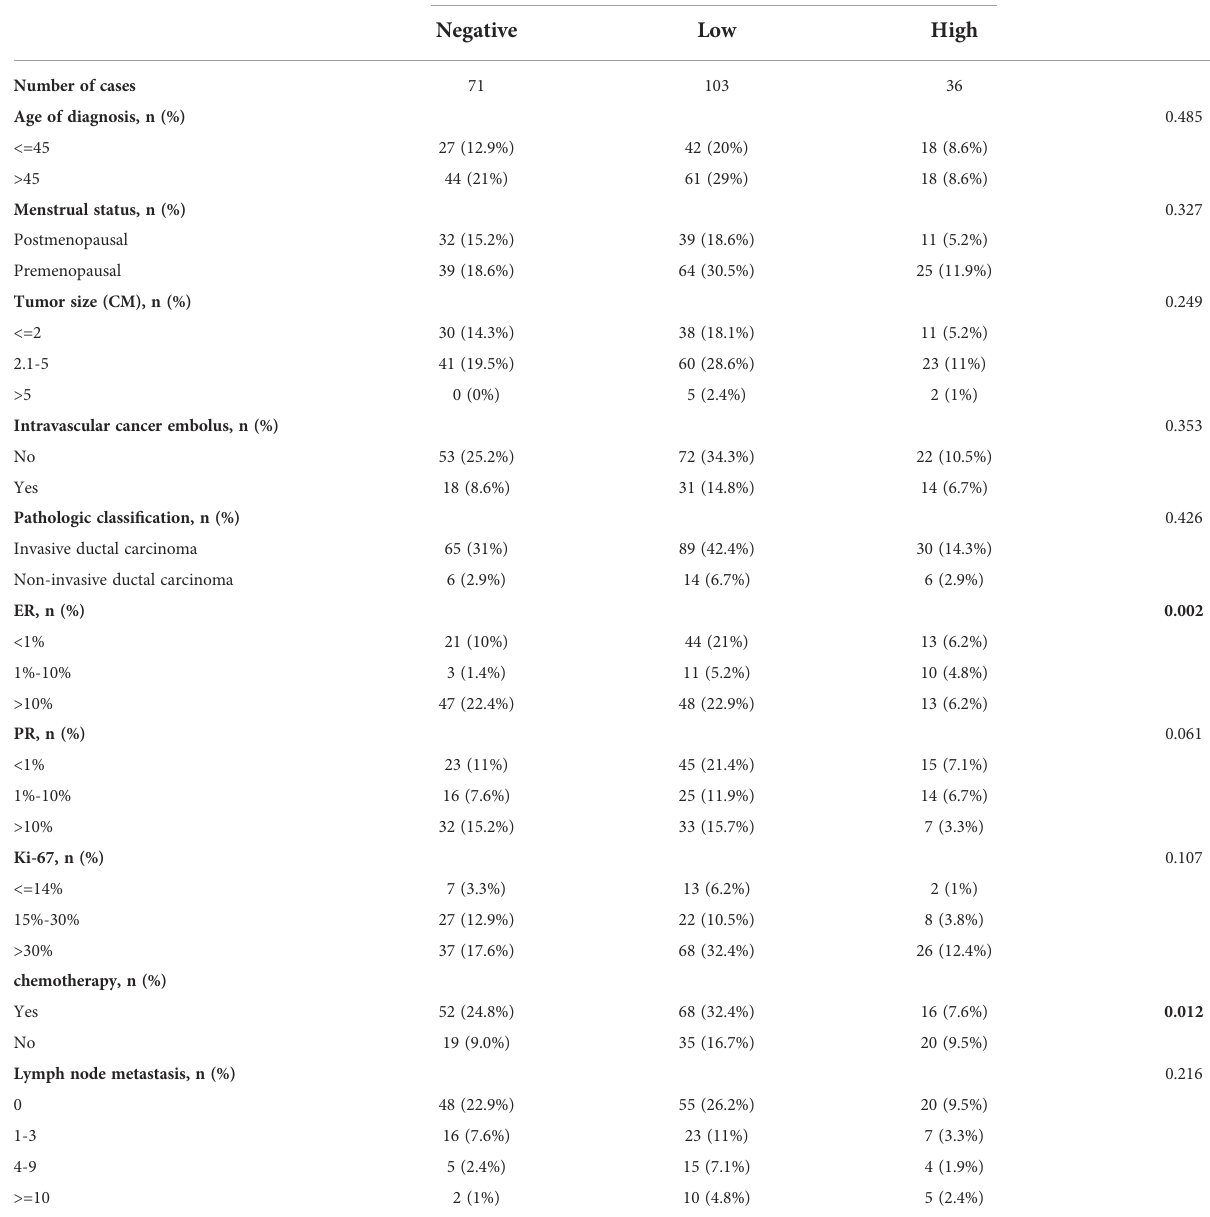
TABLE 2 Relationship between ERCC1 expression and clinical